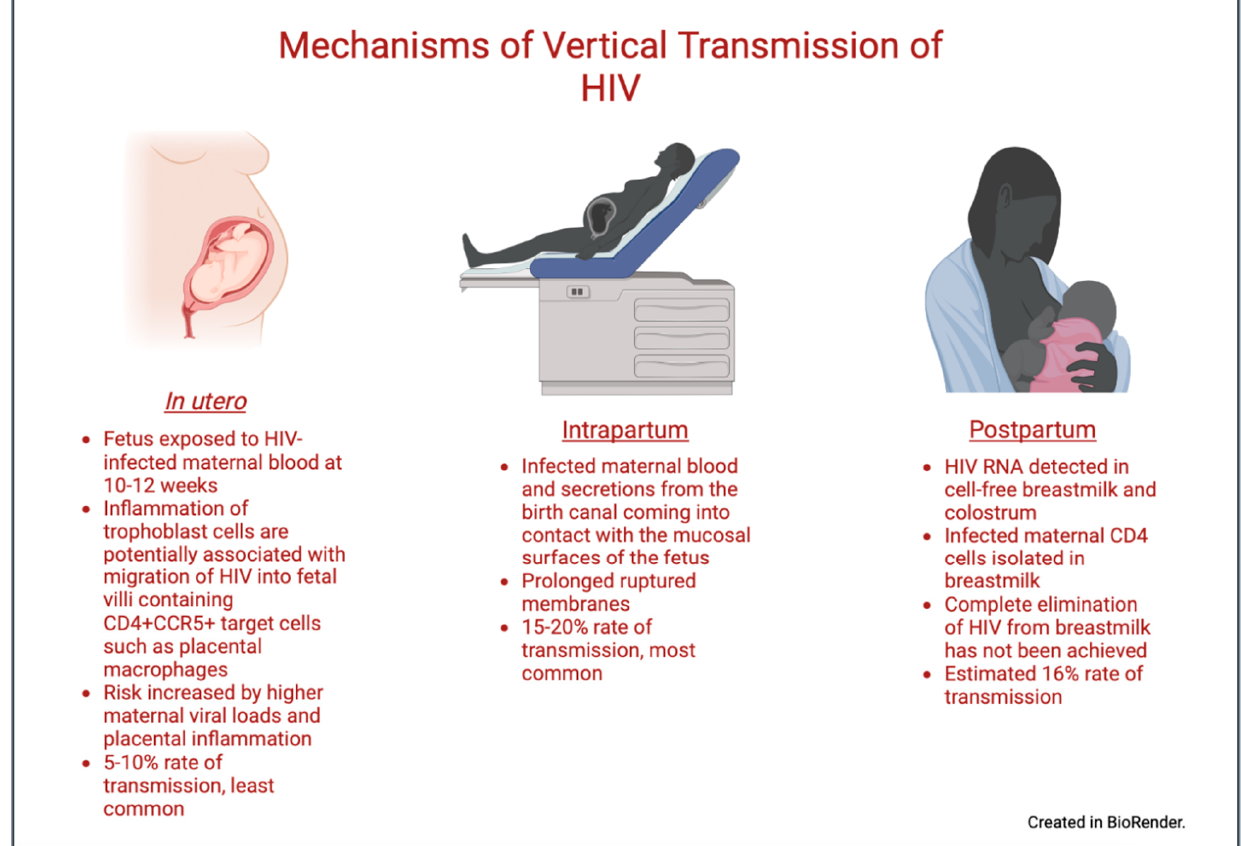
Figure 1. Mechanisms of vertical transmission. Created in BioRender.